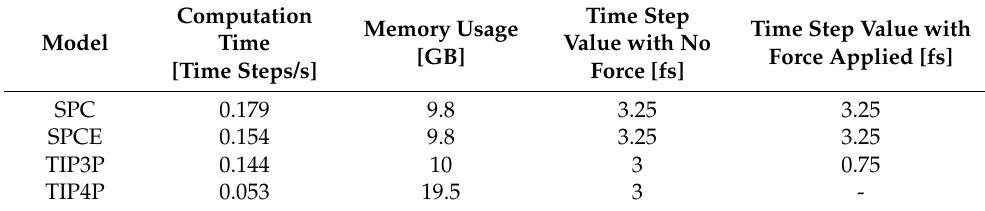
Figure 1. Scaled-down (computed simulation consisted of almost 4 million atoms) image of a simulation box filled with atoms. Water molecules were placed on a rectangular grid with 3.1 Å spacing, and in the center, was a solid particle composed of carbon and hydrogen atoms placed on a circular pattern. Table 2. Model performance and resource